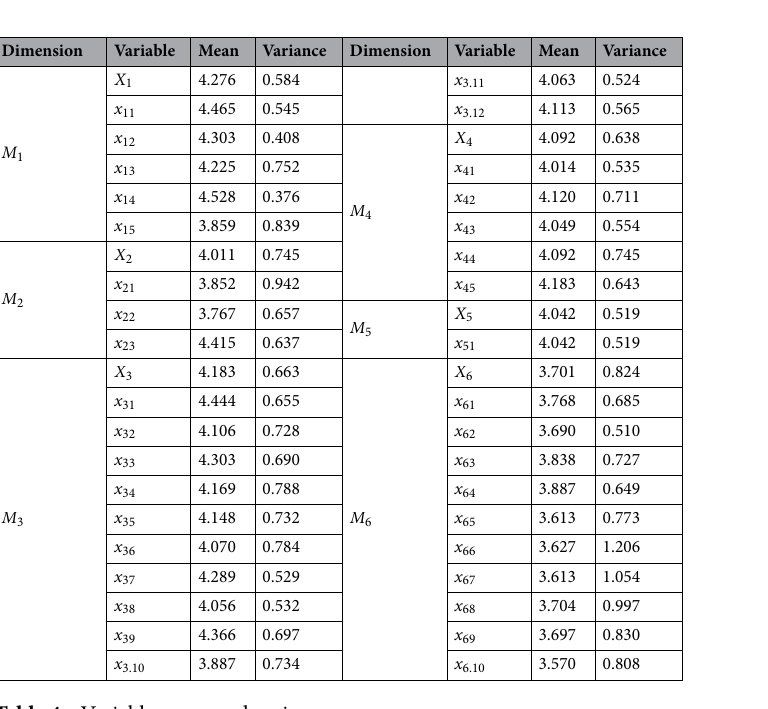
Table 4. Variable mean and variance.